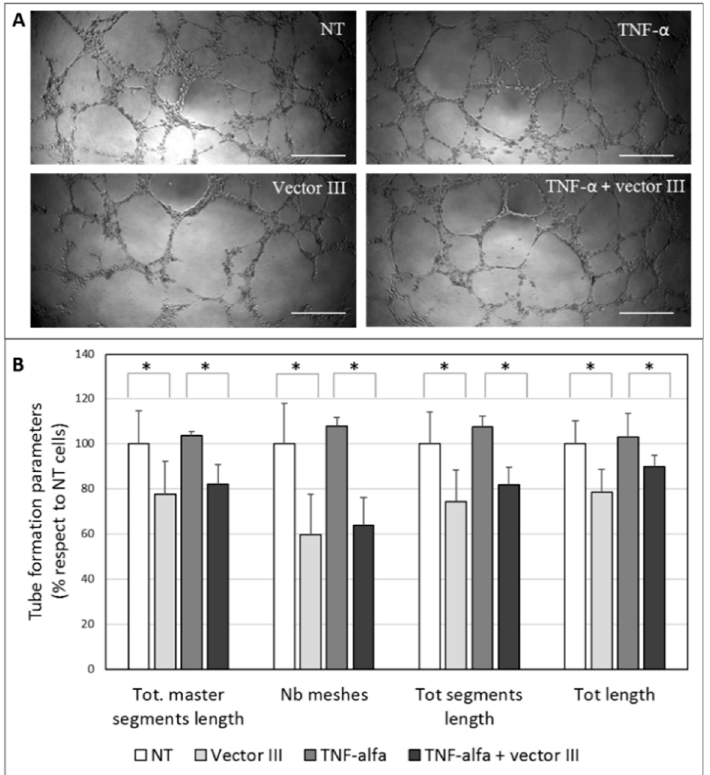
Figure 9. ( A ) The representative images obtained in the tube formation assay in human umbilical vein endothelial cells (HUVECs) and ( B ) the quantification of tube formation. Data were normalized relative to the values of non-treated cells (NT). * p < 0.05. Scale bar: 60 µm.